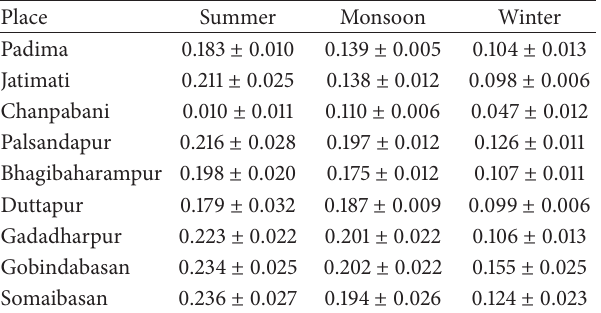
∘ slants and stored at 4 C for further characterization. Mor- Table 1: Seasonal diversity ( × 10 6 ± S.E cfu/g dry soil) of Bacillus spp. in some villages of coastal areas of Digha, West Bengal, India. Place Summer Monsoon